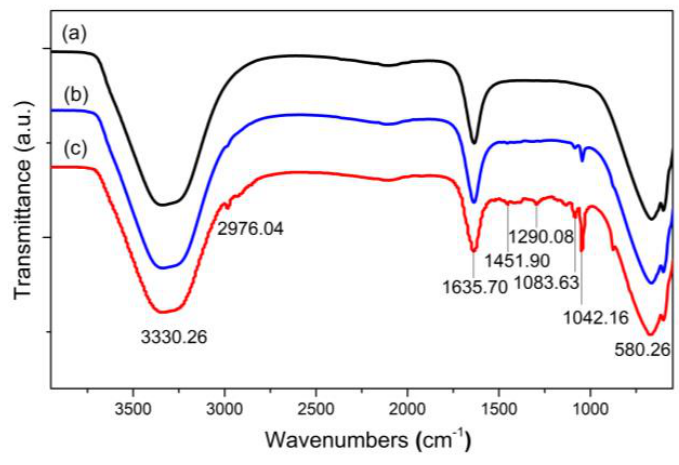
Figure 6. FTIR spectra of ( a ) Fe 3 O 4 , ( b ) FOA, and ( c ) FOASET nanoparticles. The magnetic hysteresis loop of the FOASET nanoparticles at room temperature in the applied magnetic field in the range of +100,000 to − 10,000 Oe was shown in Figure 7. The FOASET nanoparticles show a superparamagnetic property with narrow hysteresis loops and very small amounts of residual magnetism. At the applied magnetic field of ± 10,000 Oe, a magnetization of 36.41 (emu/g) was obtained. It should be noted that full saturation magnetization is not reached at H ± 10,000 Oe.